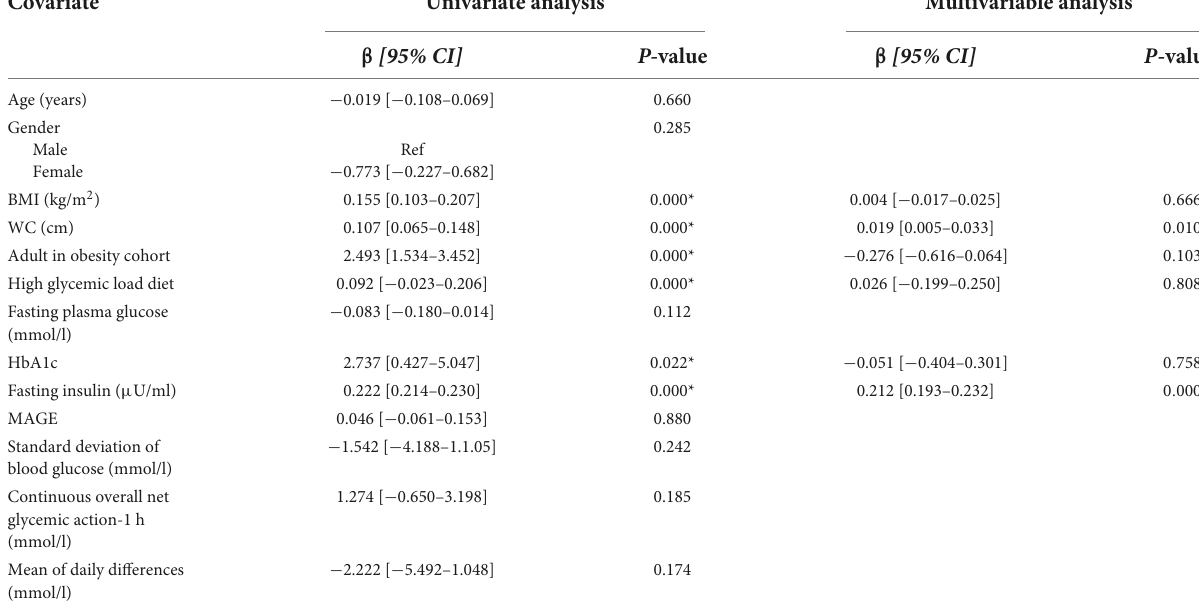
TABLE 4 Univariate and multivariable linear regression analysis of factors associated with HOMA-IR. Covariate Univariate analysis Multivariable